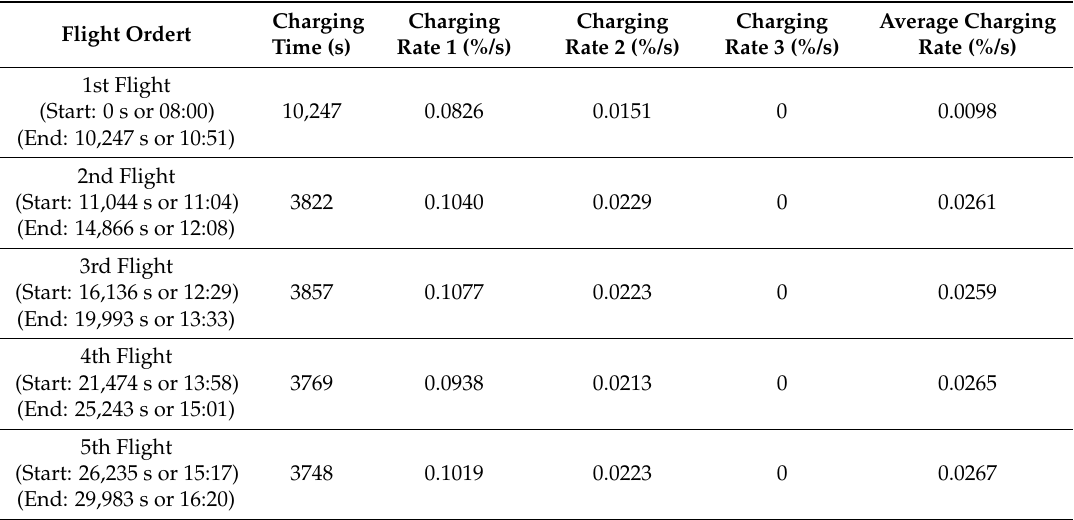
Table 6. Charging progress time and rate of five